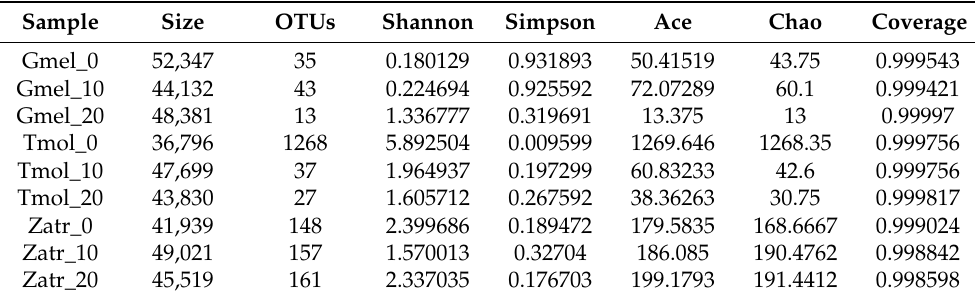
Table 2. Quality of the samples and bacterial diversity analyses based on Illumina sequencing of the 16S rRNA gene